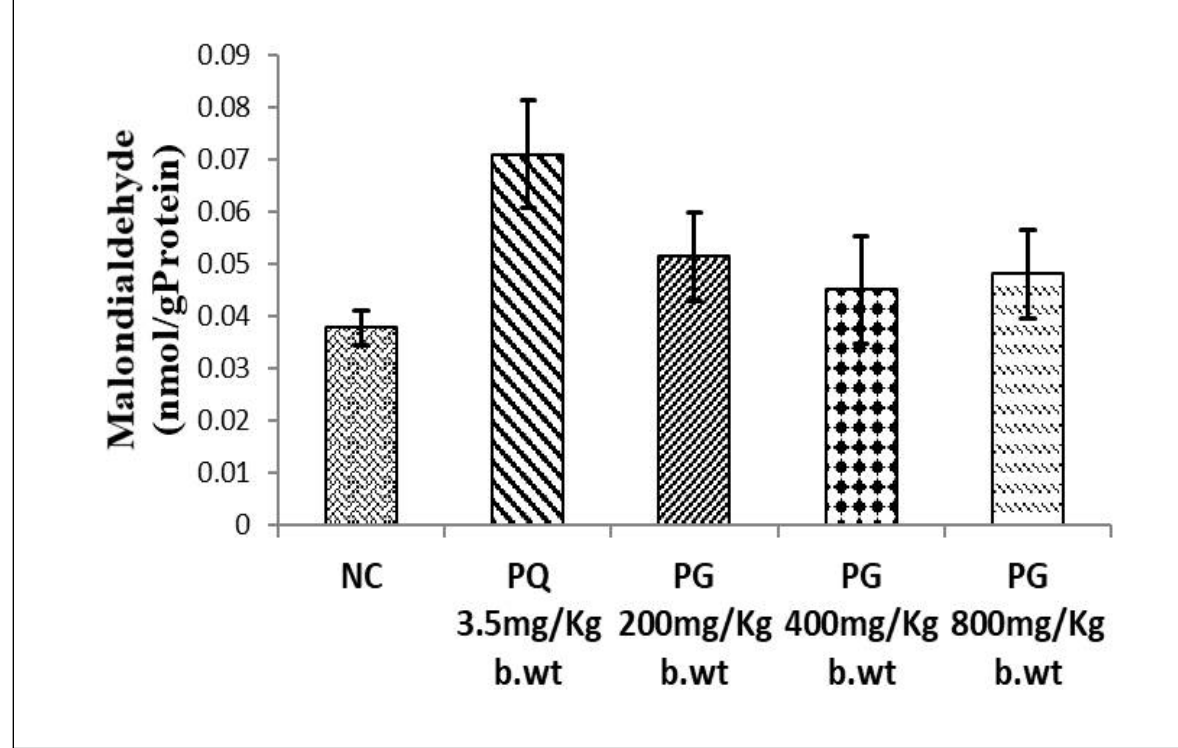
Figure 10: Effect of Psidium guajava leaf extract administration on serum malondialdehyde concentration of male Wistar albino rats administered 3.5 mg/kg b.wt. Paraquat